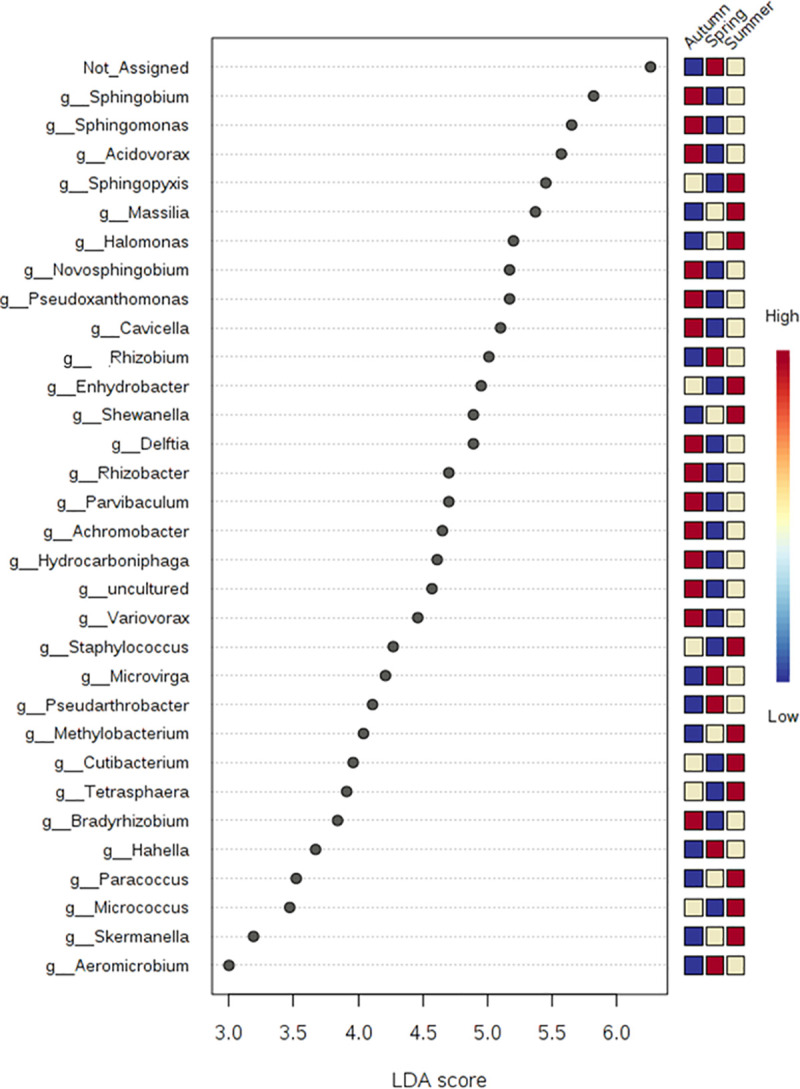
LDA analysis based on non-parametric factorial Kruskal-Wallis (KW) sum-rank test of bacterial genus among three seasons (p & q ≤ 0.05).The heat map on the right side of the figure explains the abundance of the genera in three different seasons depicted by the three colours. Blue (low abundance), beige (median abundance) and red (high abundance).